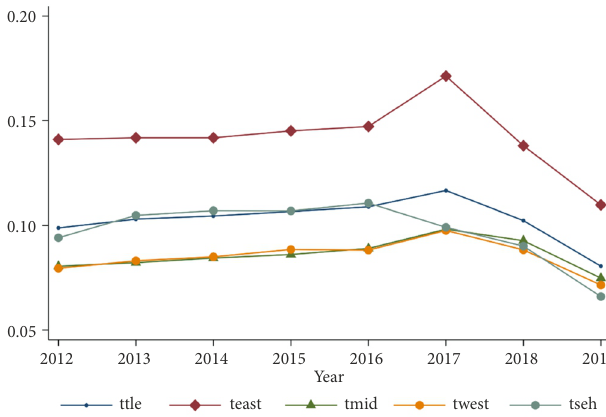
Figure 1. Trends of the urban resilience in China and four regions from 2012 to